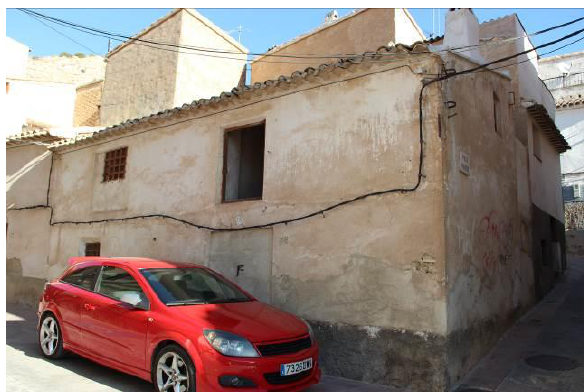
Figure 3. Humble dwelling in the upper area of Mula (Source: authors).